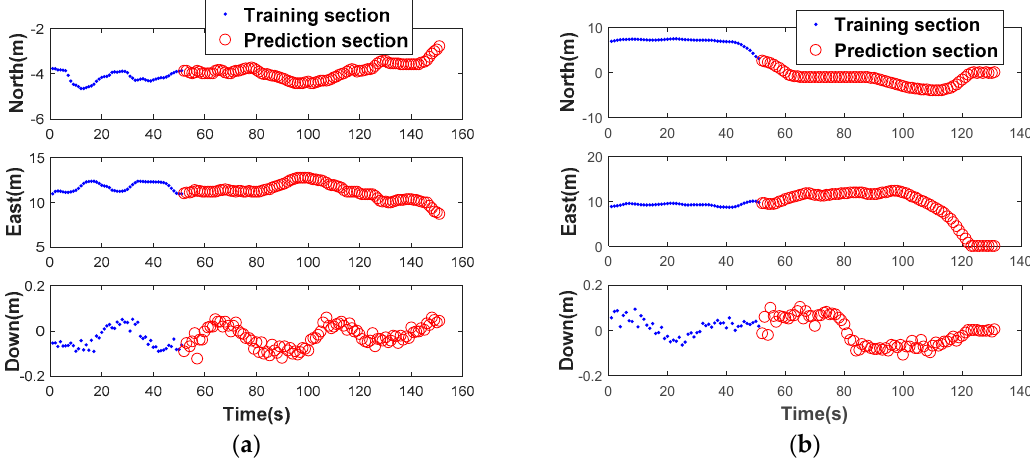
Figure 10. GPS/BDS Position increments in Test 1 ( a ) and Test 2 ( b ).